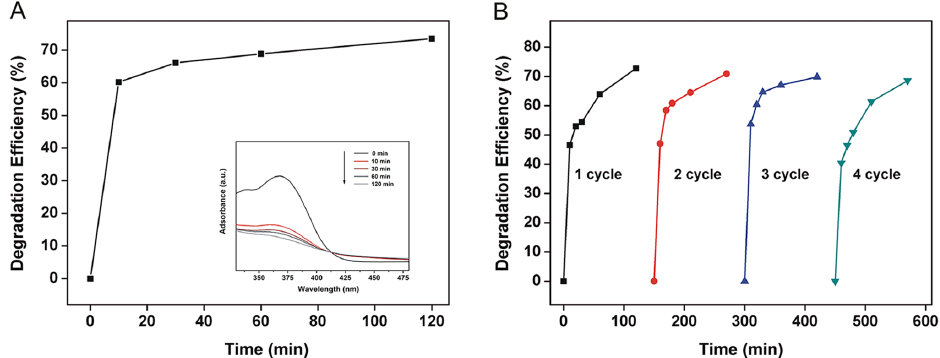
Figure 3. ( A ) DE of SSM on CTC in aqueous solution; ( B ) reusability of SSM for degradation of CTC